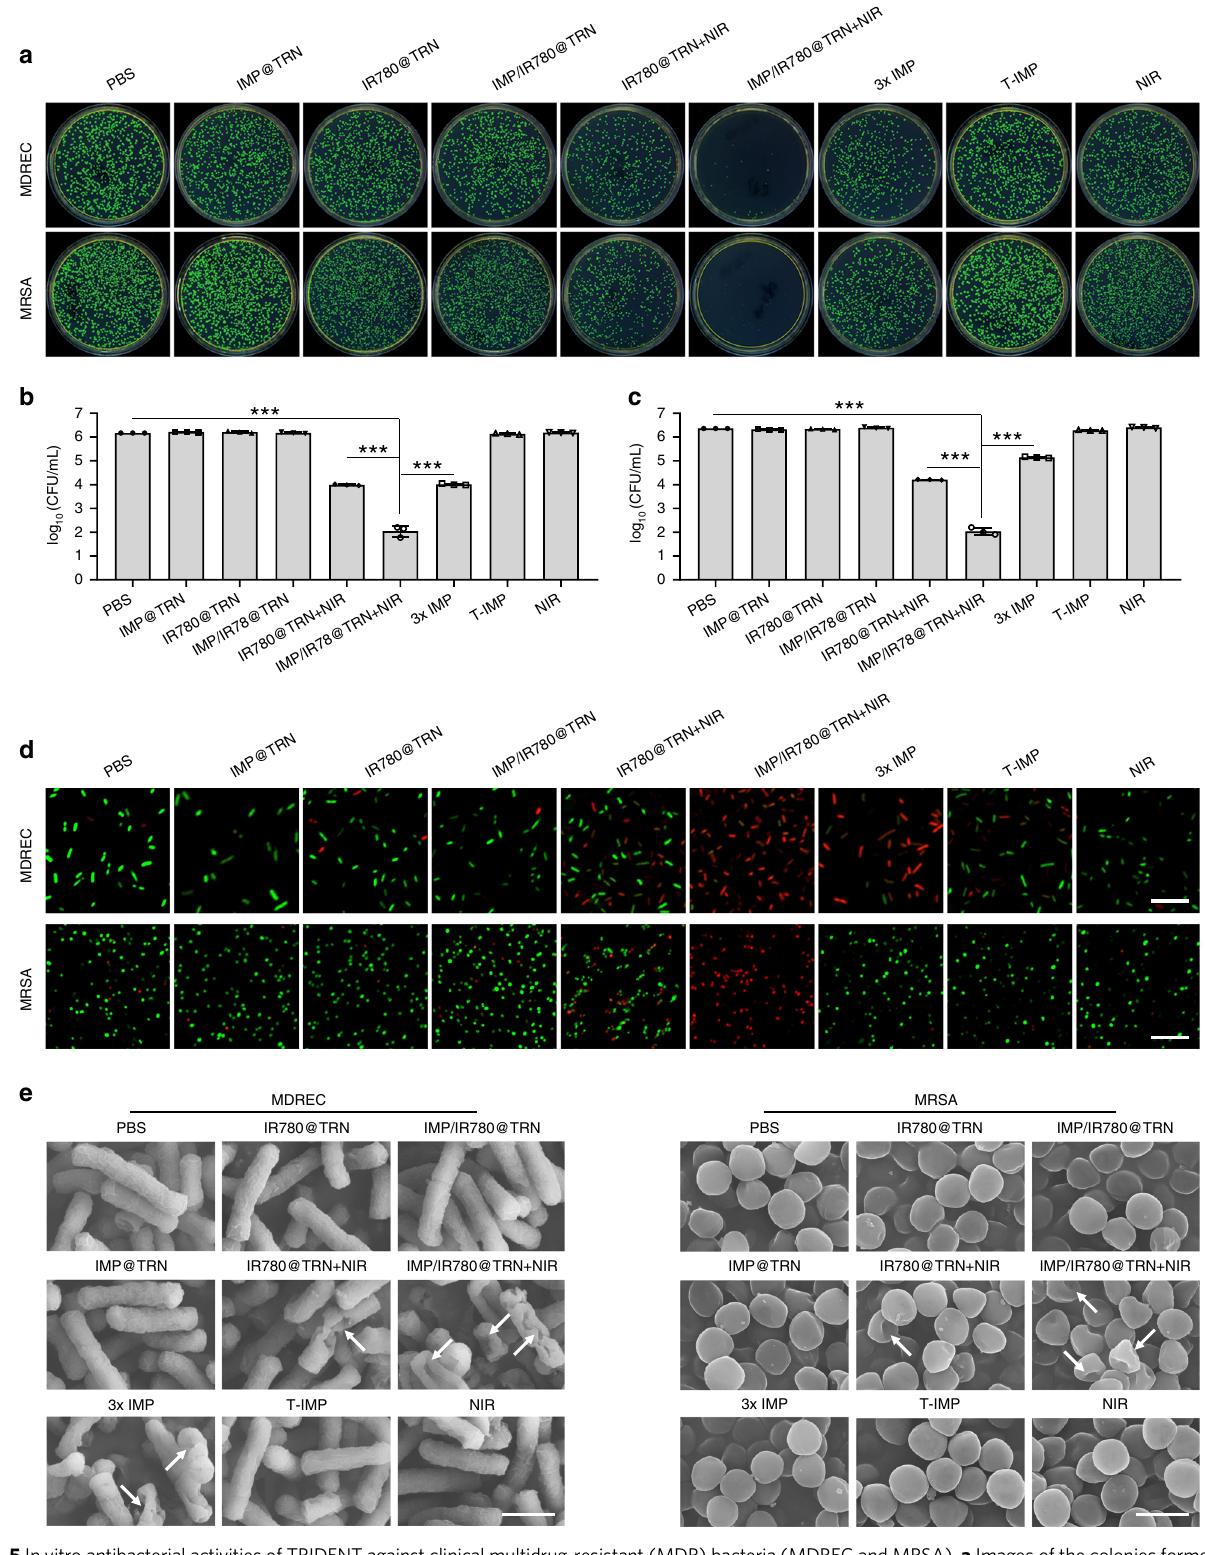
Fig. 5 In vitro antibacterial activities of TRIDENT against clinical multidrug-resistant (MDR) bacteria (MDREC and MRSA). a Images of the colonies formed on Luria-Bertani broth-agar plates. Statistical analysis of the bacterial viability by log 10 (CFU mL − 1 ) for b MDREC and c MRSA. Data are presented as mean±s.d. ( n = 3). ** p <0.01, *** p <0.001 (Student ’ s t -test). d Images of live (green fl uorescence) and dead (red fl uorescence) bacterial cells following various treatments. Scale bars: 10 μ m. e SEM images of bacteria after treatment with different groups. White arrows denote the morphological damages in bacterial cell. Scale bars: 1 μ m. Source data are provided as a Source Data fi